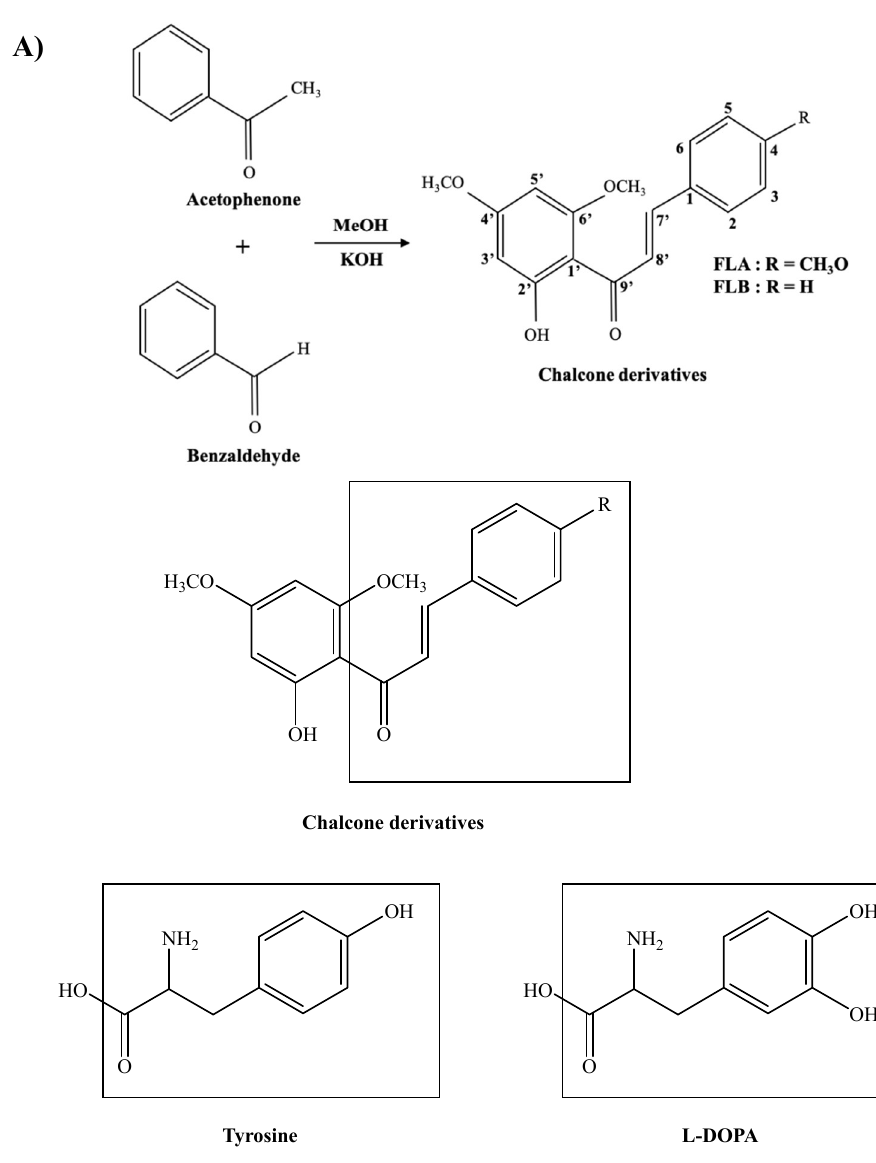
Figure 7. Synthesis of chalcone derivatives and chemical structures of compounds . ( A ) Synthesis of Flavokawain A (FLA) and flavokawain B (FLB). ( B ) Skeleton structure of chalcone resembles the skeleton structures of tyrosinase substrates which are tyrosine and L -DOPA.